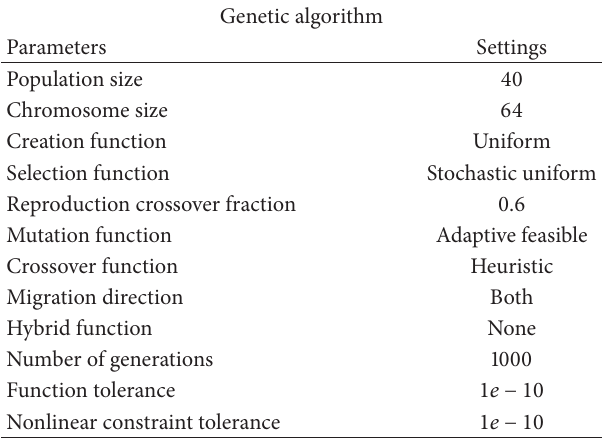
Table 3: Parameter settings of the GA.